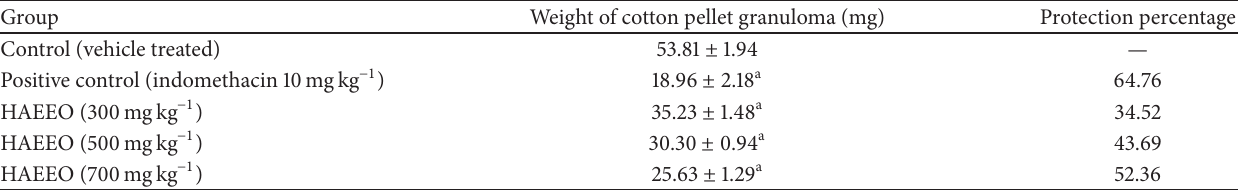
Table 2: Effect of HAEEO on cotton pellet-induced granuloma in